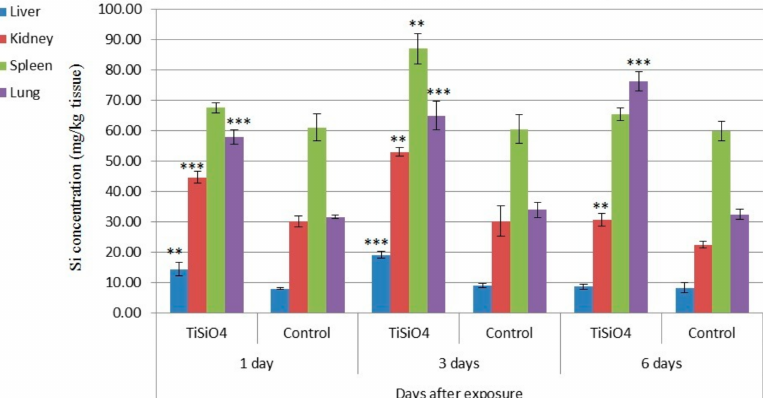
Figure 8. Silica content (mg/kg tissue) in male rat liver, kidney, and spleen tissues 1, 3, and 6 days post- oral administration of 250 mg ≤ 50 nm TiSiO 4 NPs/kg b.w. Values are the mean ± SD **: moderate significance, ***: high significance ( p <